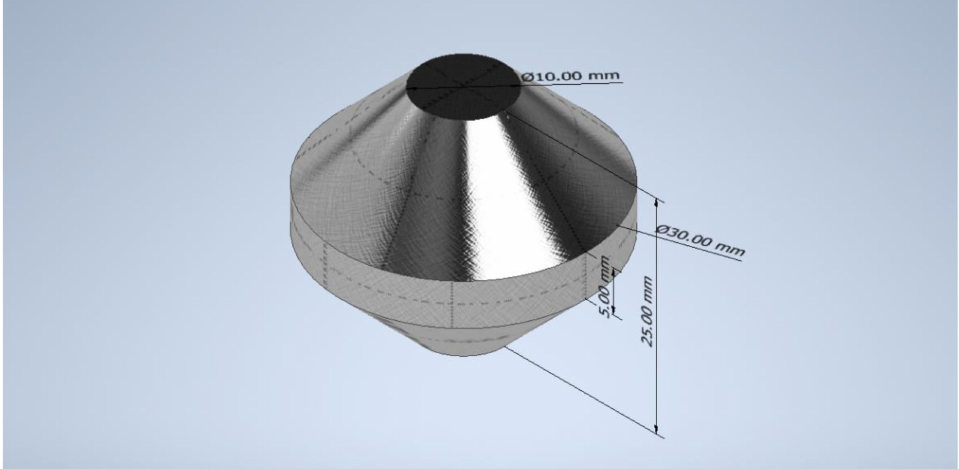
Figure 1. Double cone geometry used for compression